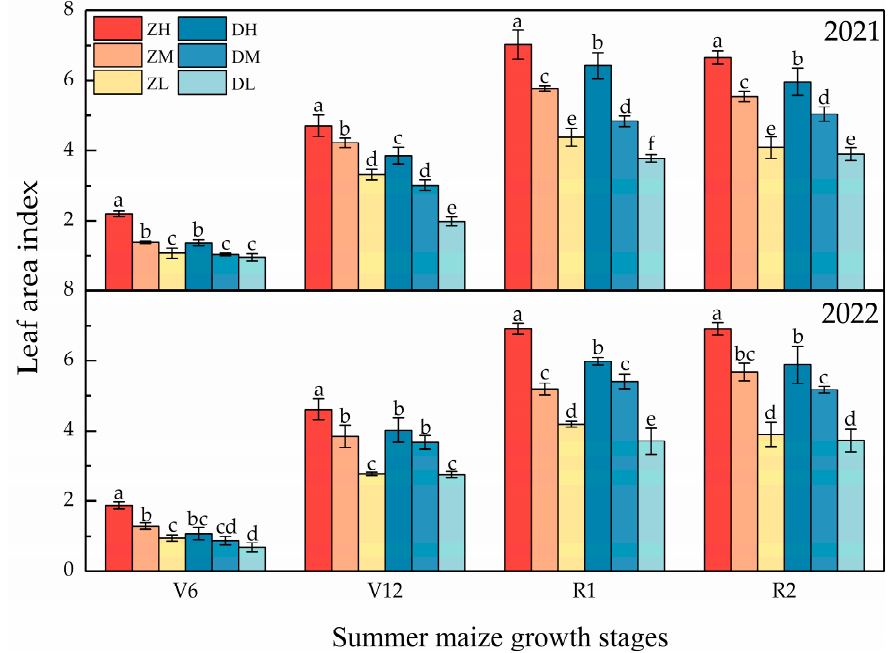
Figure 2. LAI of summer maize at different growing stages in the 2021 and 2022 summer maize growing seasons. Z represents Zhengdan 958, D represents Denghai 605; H represents high density, M represents middle density, and L represents low density. The measurement date was on 19 July, 27 July, 10 August, and 28 August, 2021; and 15 July, 27 July, 13 August, and 4 September, 2022, which belonged to V6 (the sixth-leaf stage), V12 (the twelfth-leaf stage), R1 (silking stage), and R2 (filling stage) of summer maize, respectively. Vertical bars represent standard errors. Bars labeled at the top of the column with different letters are significantly ( p < 0.05) different among treatments using LSD post hoc test.